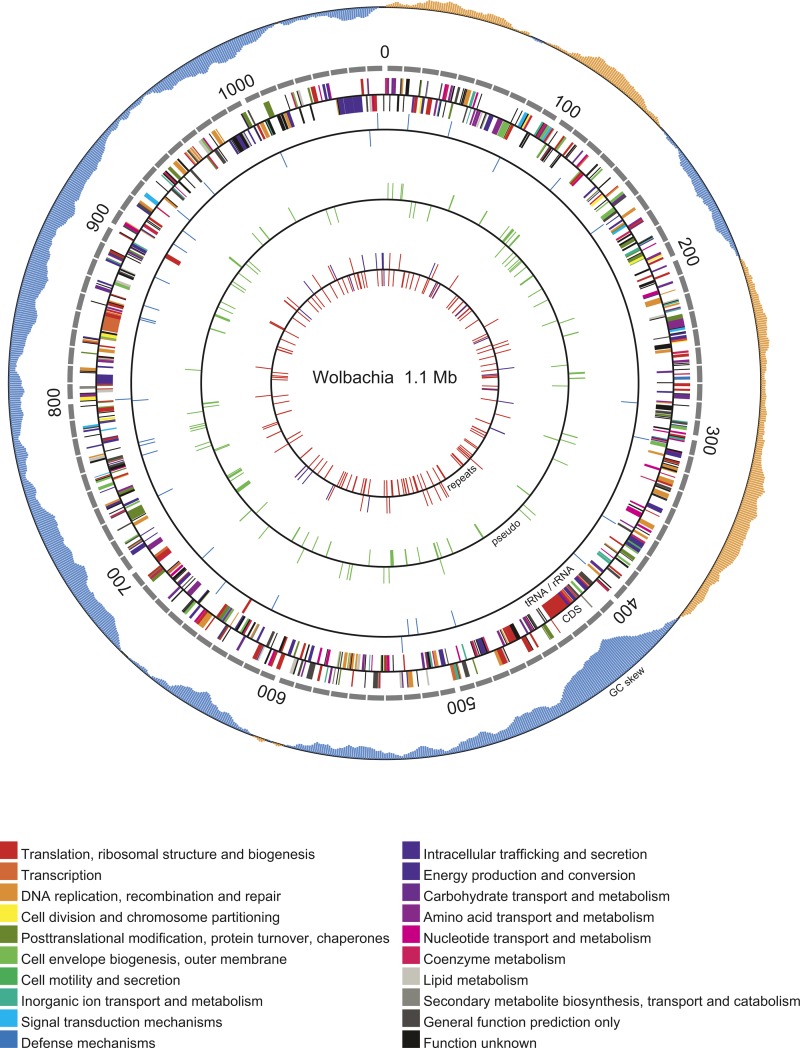
Genogram of the Complete Circular Genome of wBmThe scale indicates coordinates in kilobase pairs (kbp) with the putative origin of replication positioned at 0 kbp. The outermost ring indicates the GC-skew over all bases in the forward strand using a window size of 40 kbp and a step size of 1 kbp. Positive and negative skew are shaded gold and blue, respectively. Features are shown as paired rings separated by a circular baseline. In each pair, the outer and inner rings represent the forward and reverse DNA strands, respectively. Working inward from the scale, the features displayed are as follows: identified genes and their broad functional classification (multihued, as listed); tRNA (blue)/rRNA (red) genes; putative pseudogenes (green); repeated sequences (red) and transposon-related repeats (blue).